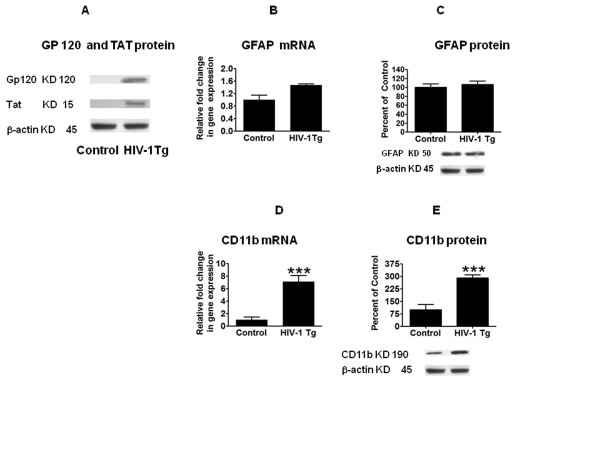
(A) Representative immunoblot of gp120 and tat protein in HIV-1 Tg rat brain (A), detected as described in Methods. mRNA levels of brain GFAP (B) and CD11b (D) in control and HIV-1 Tg rat brain, measured using real time RT-PCR, normalized to β-globulin and relative to control level (calibrator) using the ΔΔCT method. Representative immunoblots of (C) GFAP and (E) CD11b protein in control and HIV-1 Tg rat brain. Bar graphs are ratios of optical densities of individual protein bands to β-actin, expressed as percent of control. Data represent mean ± SEM, statistical significance: **p < 0.01, ***p < 0.001 as determined by unpaired t-test.